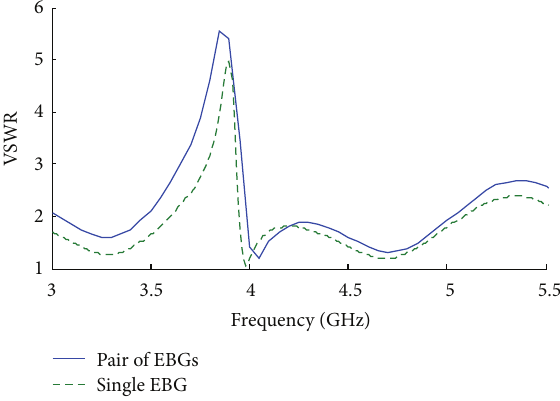
Figure 2: Notch characteristics for pair and single EBG